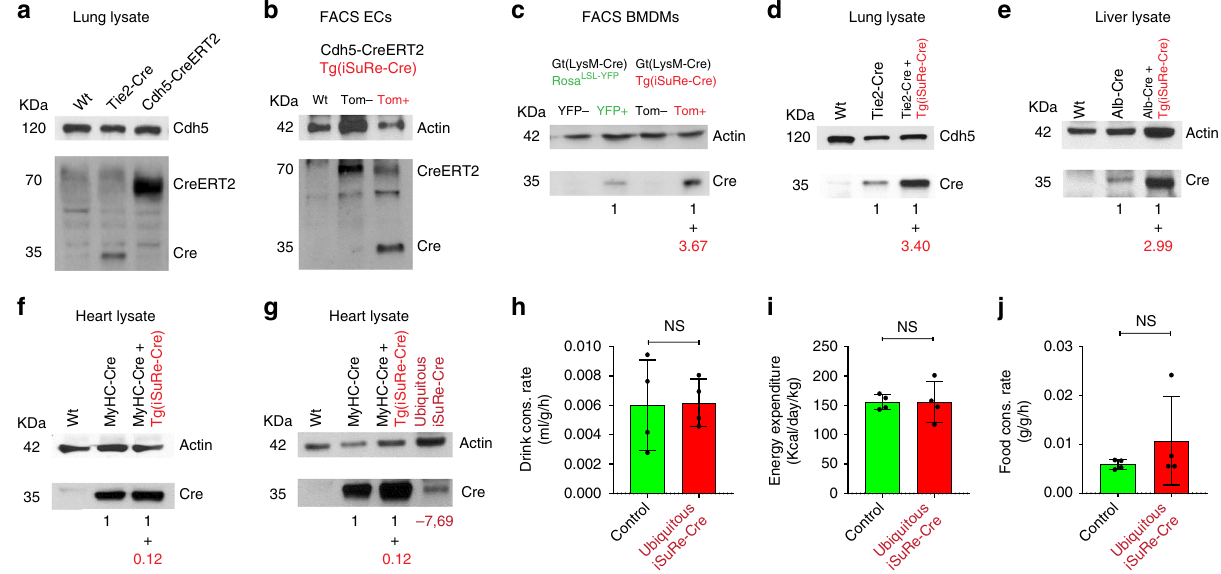
Fig. 7 Comparison of Cre expression levels in different tissues and mouse lines. a Western blot analysis of lung lysates from mice with the indicated genotypes, showing Cre (35kDa) and CreERT2 (70 kDa) expression differences in Tie2-Cre and Cdh5-CreERT2 mouse lines. b Western blot analysis of FAC-sorted endothelial cells (CD31-APC + ) from the indicated mice, showing Cre (35kDa) and CreERT2 (70 kDa) expression in wild-type, MbTomato + and MbTomato − cells. c Western blot analysis of FAC-sorted bone marrow-derived macrophages (BMDMs) obtained from the indicated mice. d , e Western blot analysis of lung and liver lysates from mice with the indicated genotypes, showing the increase in Cre protein levels in tissues of animals with expression of the Tg(iSuRe-Cre) allele. f Western blot analysis of heart lysates from mice with the indicated genotypes, showing no signi fi cant increase in Cre protein levels in tissues of MyHC-Cre + Tg(iSuRe-Cre) animals. g Western blot analysis of heart lysates showing that animals with recombination of the Gt(Rosa)26Sor-iSuRe-Cre allele in the germline, and with ubiquitous iSuRe-Cre expression in their hearts (not only MyHC-Cre + cardiomyocytes), have signi fi cantly lower Cre levels than MyHC-Cre + hearts. h – j Metabolic studies in adult littermate mice (9 months old, n = 4 per group) having or lacking ubiquitous expression of the Gt(Rosa)26Sor-iSuRe-Cre allele. Values in red below the blots indicate the fold change in Cre protein relative to Tg(iSuRe-Cre) allele expression. Error bars indicate StDev; NS nonsigni fi cant. Two-tailed unpaired t -test. Source data are provided as a Source Data fi